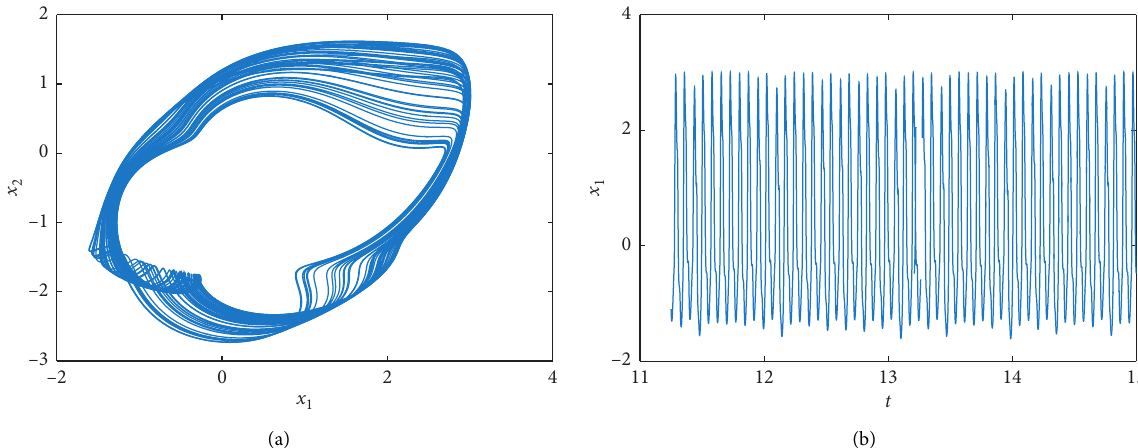
Figure 8: Phase portrait on plane ( x motion when P